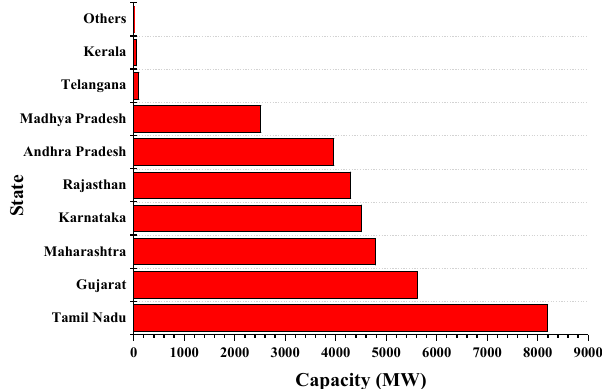
Figure 11. Installed wind capacity by state as of 31st March 2018 in India.